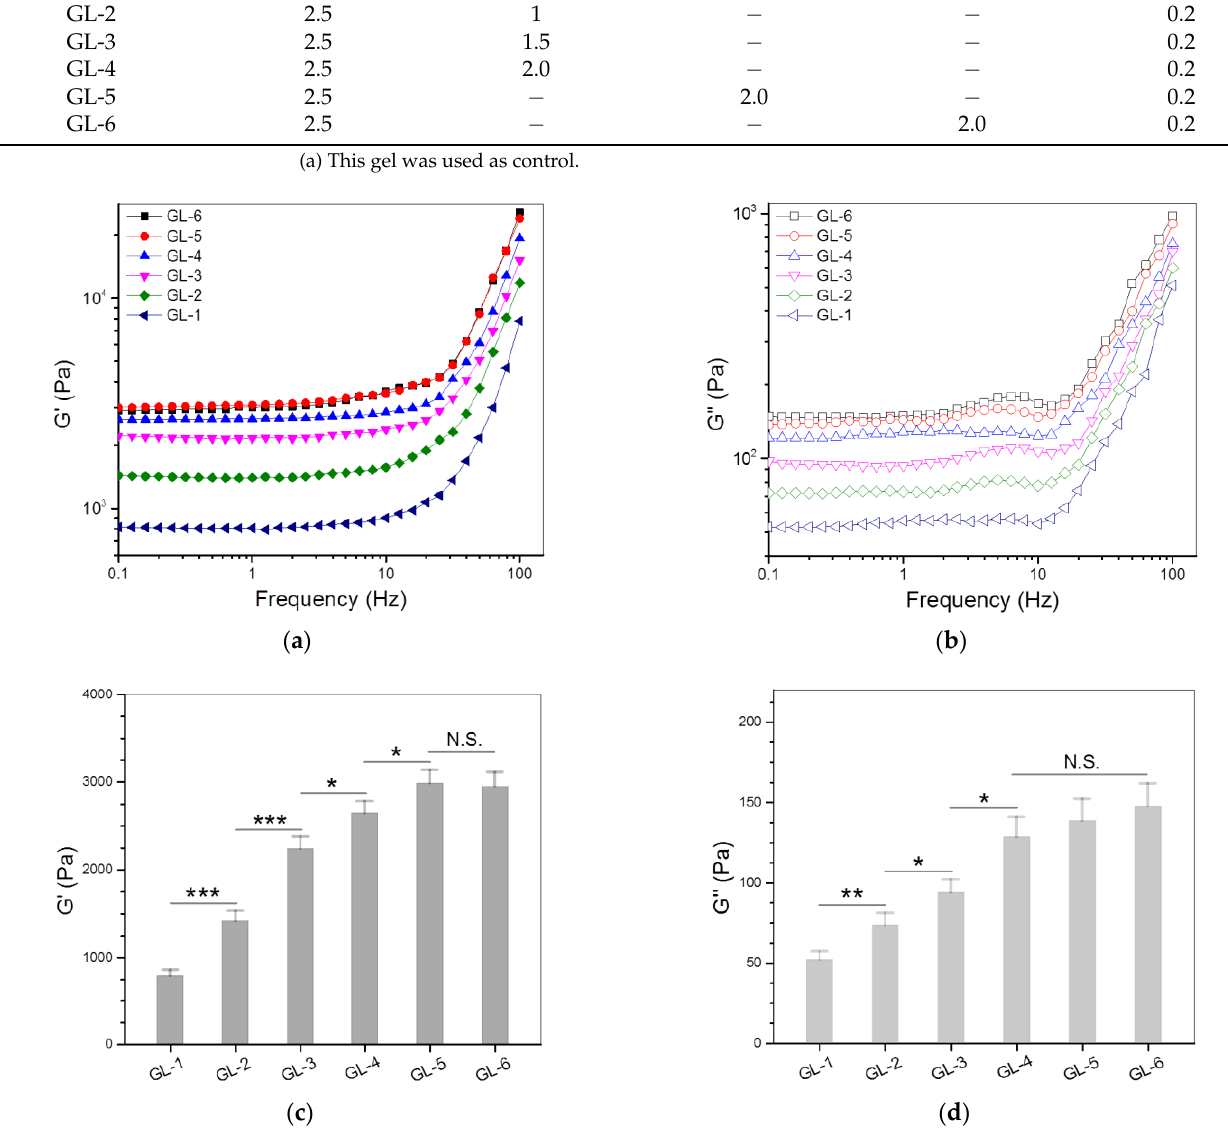
Figure 4. Frequency-dependent variations in G ′ ( a ) and G ″ ( b ) as well as average values of G′ ( c ) and G″ ( d ) at 1 Hz for gels illustrated in Table 2 (*, p < 0.05; **, p < 0.01; ***, p < 0.001; N.S., not significant).